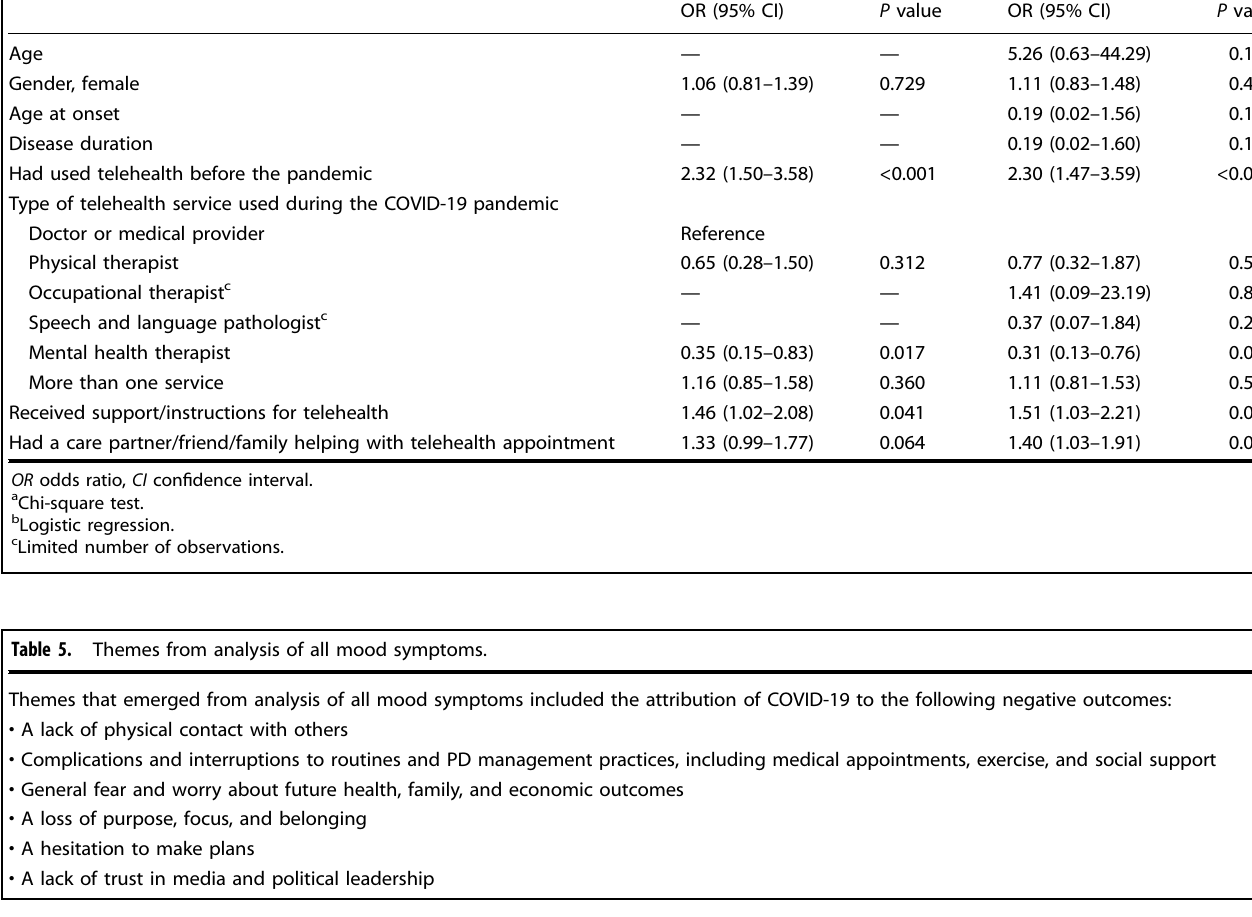
Table 4. Adjusted analysis using interest in continuous use of telehealth after the COVID-19 pandemic ends (always or sometimes) as outcome. Predictors